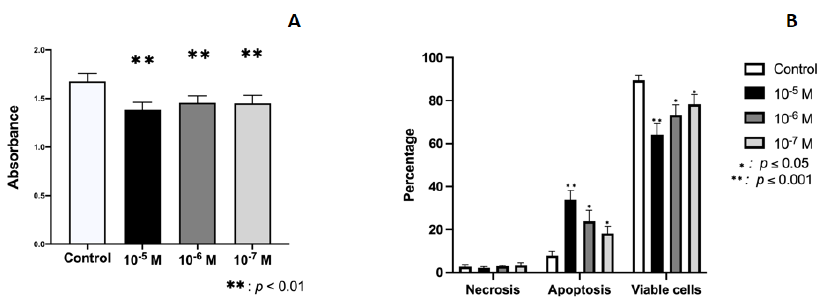
Figure 1. Effect of BPA at different doses (10 − 5 , 10 − 6 , or 10 − 7 M) on osteoblast growth and cellular viability in primary cell lines after 24 h of incubation. ( A ) Effect on cellular proliferation. ( B ) Effect on induction of apoptosis/necrosis. Data are expressed as means ± standard deviation. Significant differences * p < 0.05; ** p < 0.001.